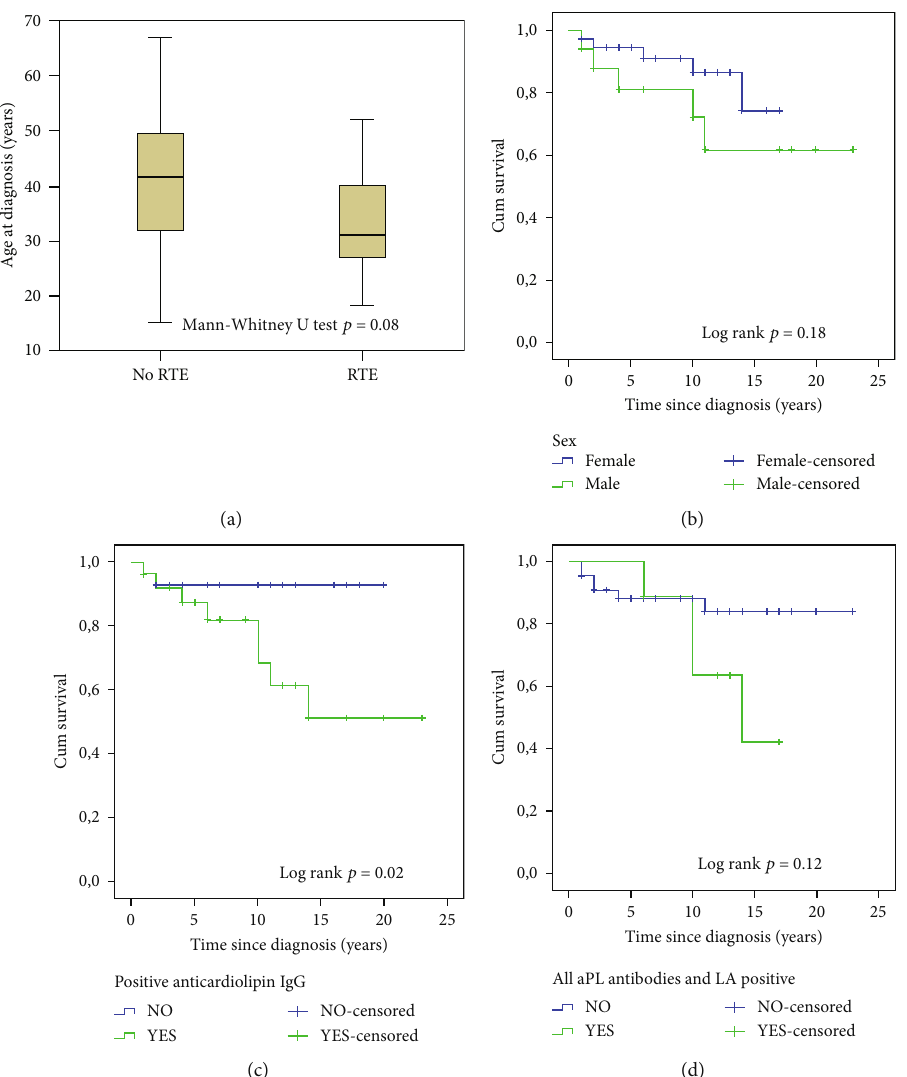
Figure 1: Shown are di ff erences between repeated thrombotic event (RTE) and non-RTE groups regarding: age at diagnosis (a), Kaplan-Meier curves where the event is “ the occurrence of a RTE after an initial PAPS diagnosis ” for sex (b), positive anti-cardiolipin IgG antibody (c), and full aPL and LA positivity